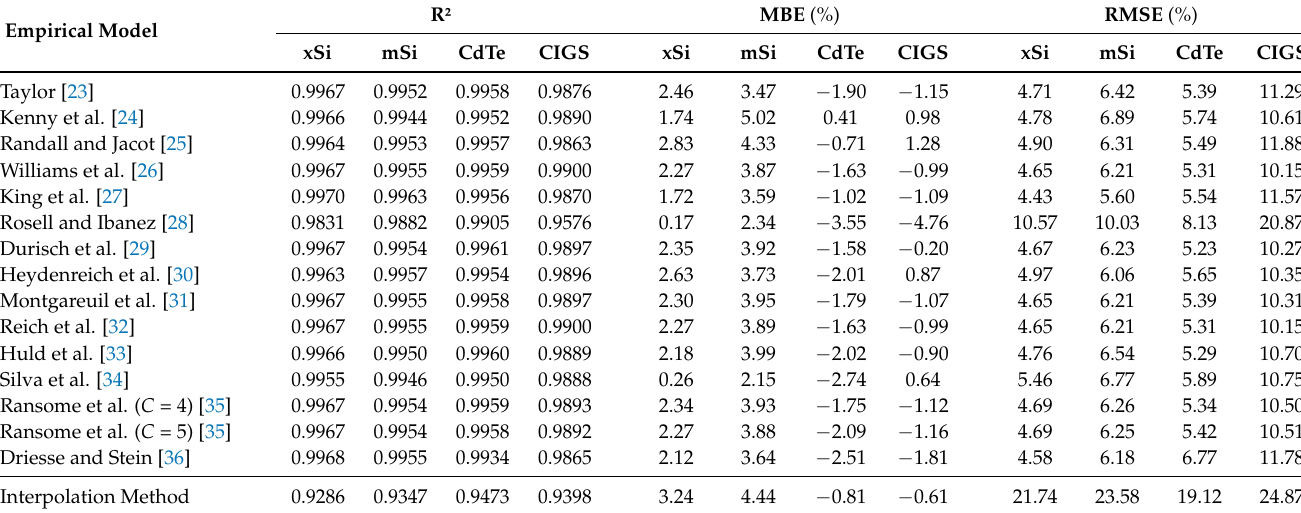
Table 3. Assessment metrics calculated from the results obtained by each empirical model for each PV technology in the study, when they were applied considering the proposed approach, and by the interpolation method that was recommended by IEC